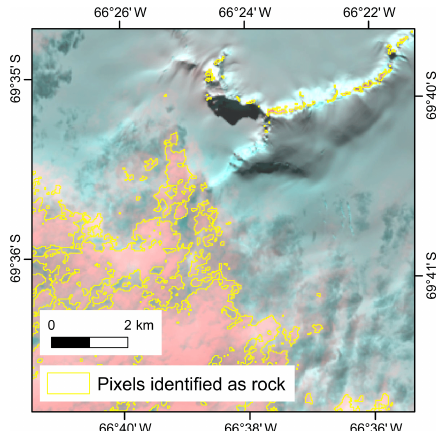
Figure 3. Illustration of the misclassification of cloud cover as rock pixels when using the NDSI technique. As in Fig. 1, the ex- ample uses a false-colour image using the band combination red: SWIR2; green: blue; and blue: blue. An NDSI threshold of 0.6 is used here to identify the rock outcrops, but at this threshold much of the cloud cover is also included. The Landsat 8 scene used is